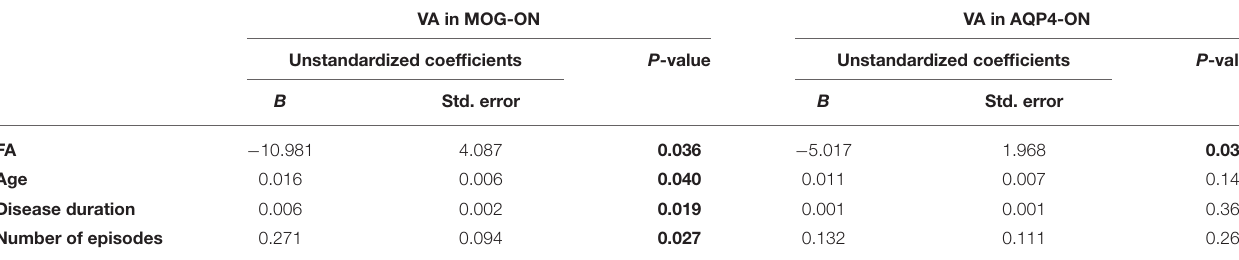
TABLE 3 | Linear regression of visual acuity with MOG-ON and AQP4-ON. VA in MOG-ON VA in AQP4-ON P -value